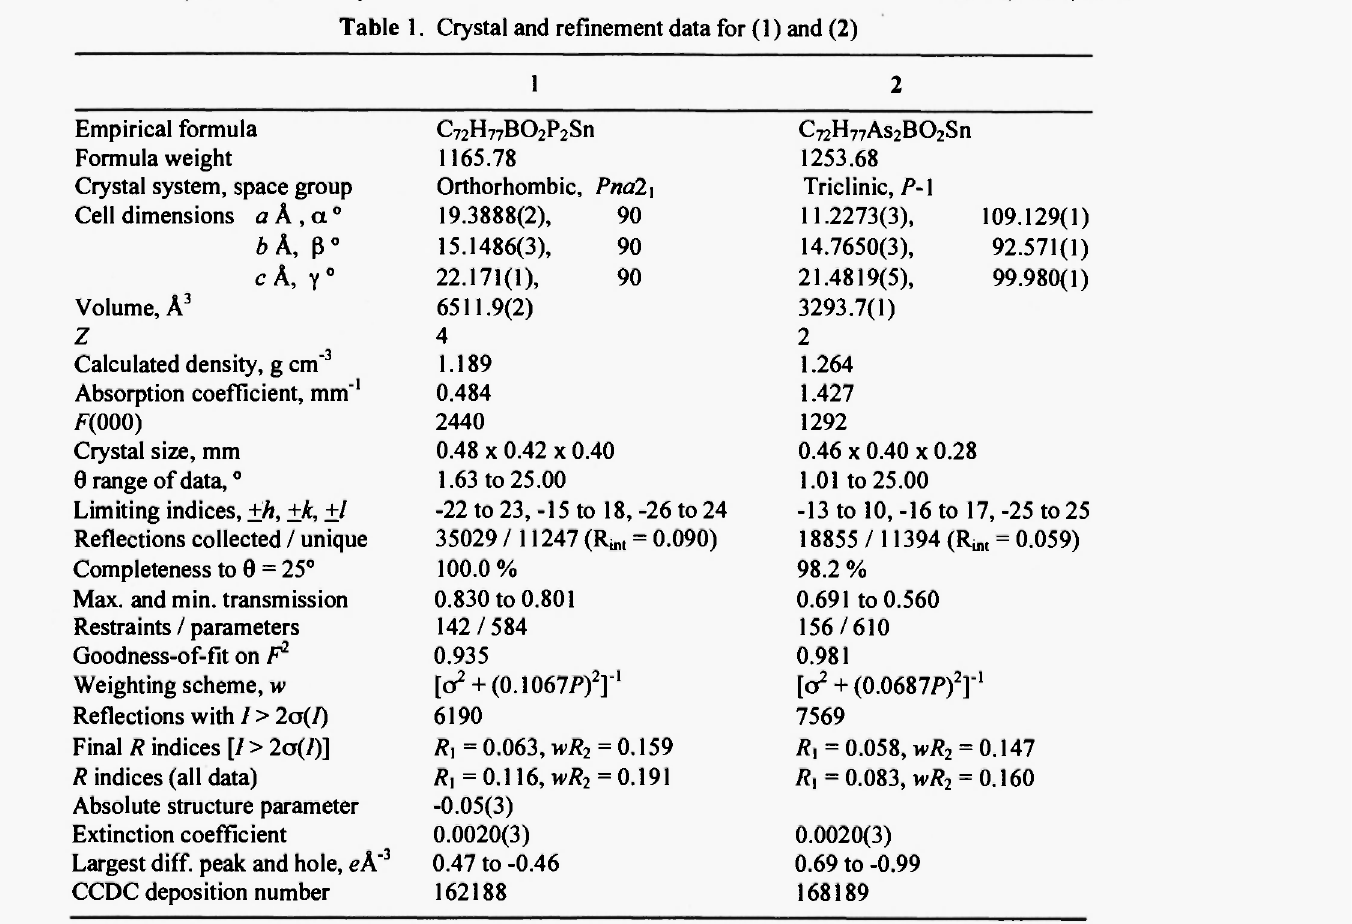
Table 1. Crystal and refinement data for (1) and